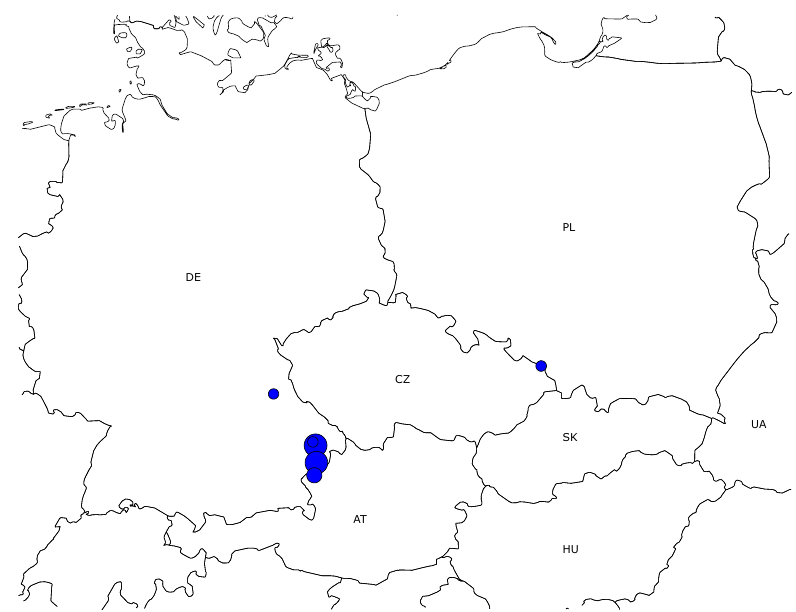
Figure 2. Top 6 locations according to the top 9 MI values (cf. Table 3). The volume of the circle at location is proportional to the MI aggregated for branches in the same location. Source: own